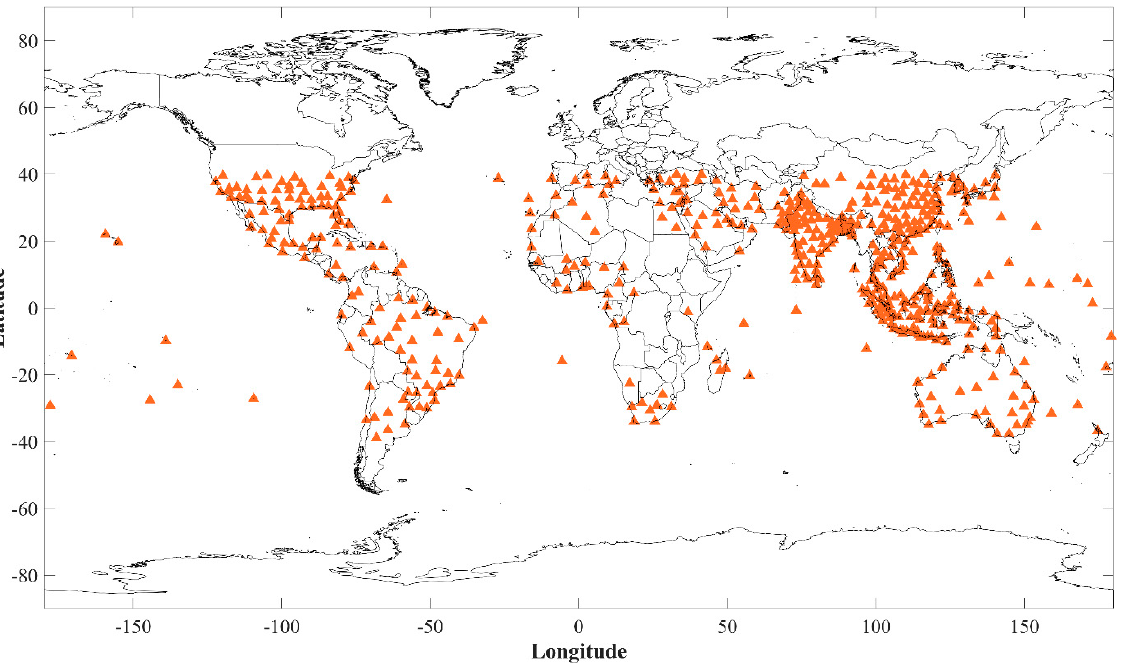
Figure 16. Locations of the radiosonde stations used for the validation using KGE metric. Table 10. KGE values for the CubeSats and COSMIC-2 profiles against the radiosonde